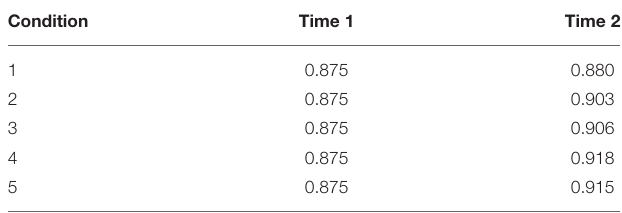
TABLE 13 | Classification accuracy: Proportion correctly